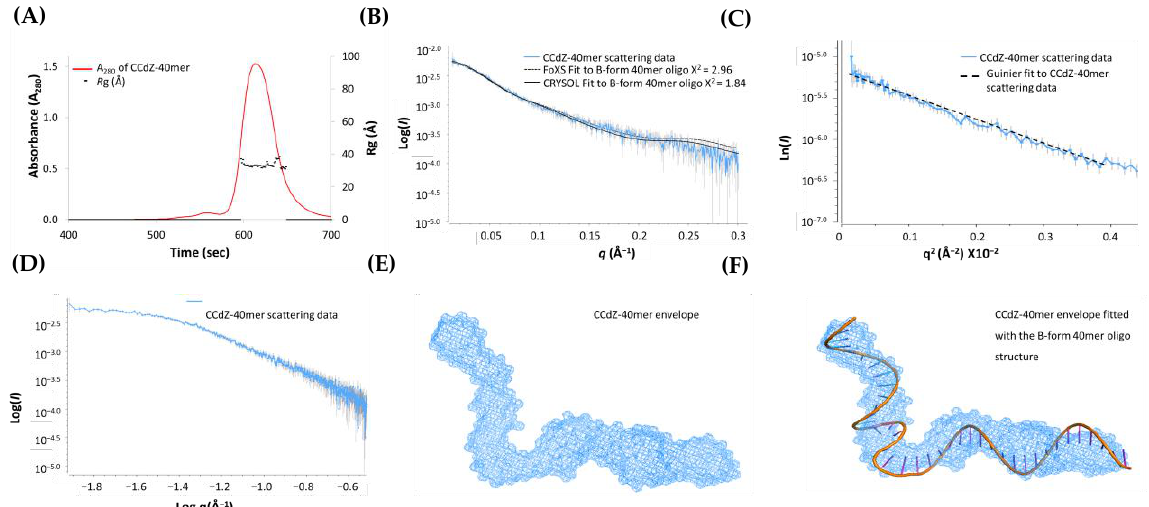
Figure 3. SEC-SAXS analysis of CCdZ-T30-oligo. ( A ) SEC elution profiles (red) of CCdZ-T30-oligo (further abbreviated as CCdZ-40mer in the figure), with R g trace (black dots) superimposed. Only the data between the thickened black lines on the x -axis were retained for analysis. ( B ) Fits of a kinked B-DNA model to SAXS X-ray data (blue) for the CCdZ-T30-oligo using FoXS (dashed black line) and CRYSOL (solid black line). ( C ) Guinier plot of CCdZ-T30-oligo scattering data (blue) and its fit (dashed black line). ( D ) Double log plot of CCdZ-T30-oligo scattering data. ( E ) Averaged envelope model of CCdZ-T30-oligo assuming P1 symmetry using DAMMIF and refined with DAMAVER and DAMFILT (ATSAS 2.8.3 suite). ( F ) Envelope model (blue shape) superimposed with the B-form of DNA for CCdZ-T30-oligo (centipede cartoon model).